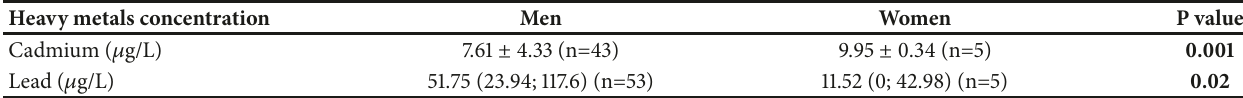
Table 5: Heavy metals concentration according to the